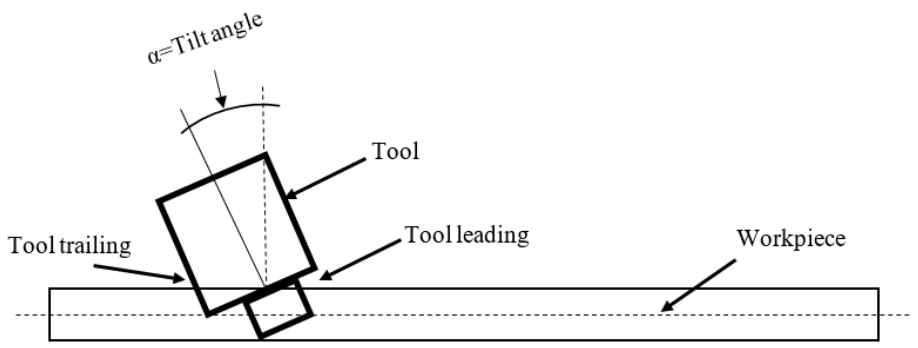
Figure 1. An exaggeratedly cross-sectional view of the workpiece and the tool at the longitudinal direction while the tilt angle is applied.